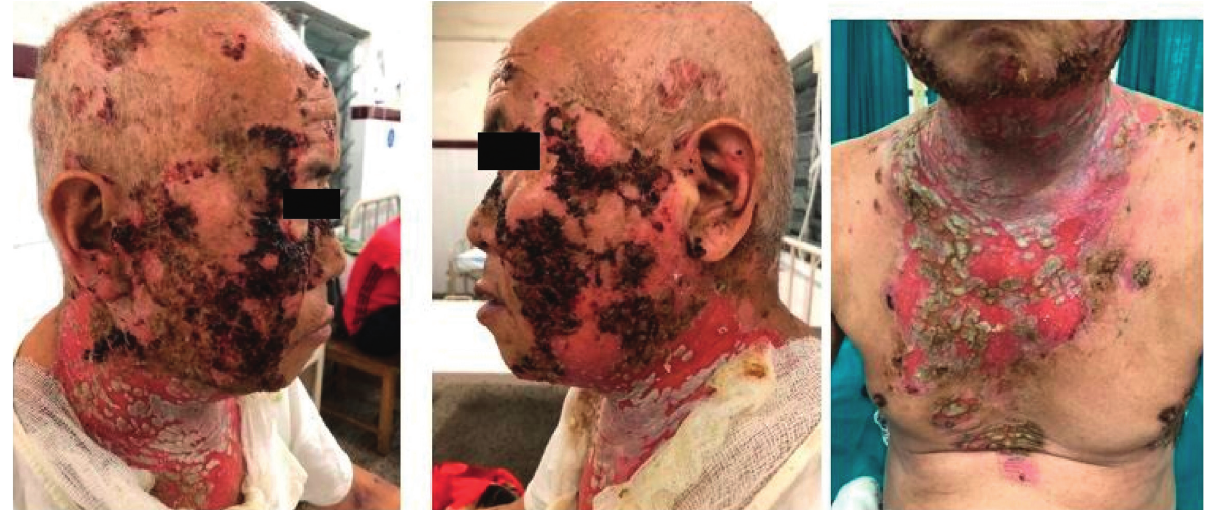
Figure 5: Day 27 of admission: further extension of haemorrhagic crusts.